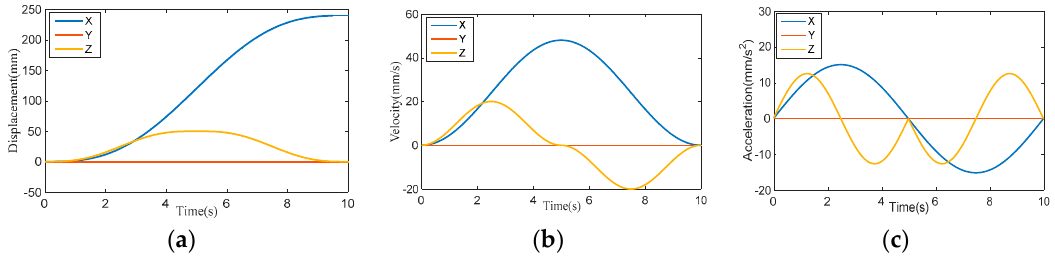
Figure 14. Snapshot of the motion simulation system for the CMBOT.